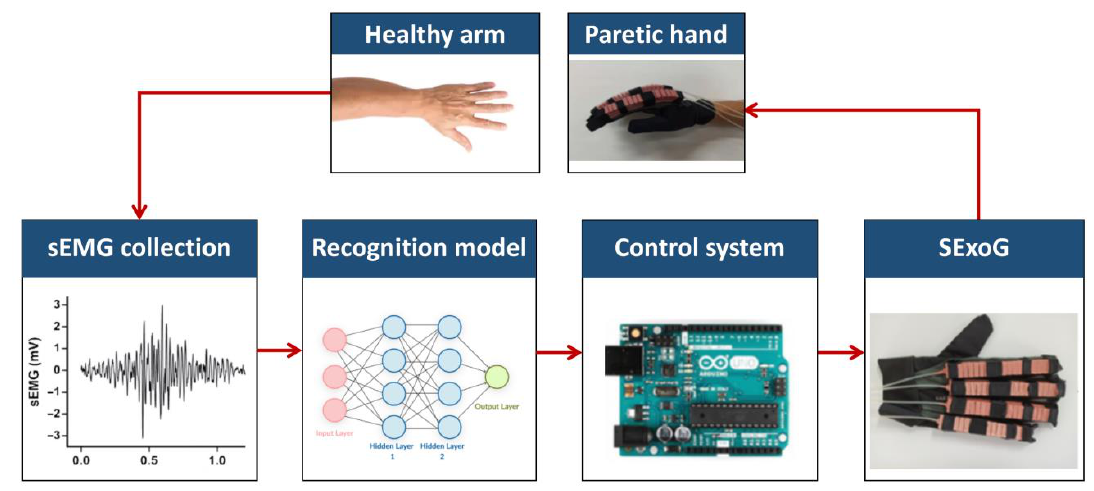
Figure 2. System diagram of the SExoG.